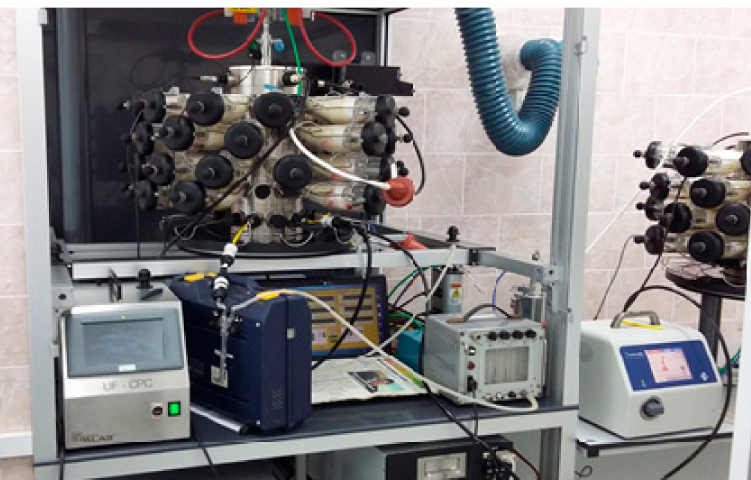
Figure 5. The nose-only inhalation setup (photographed without the door wings of the draught cupboard) and a similar tower for the sham exposure of the control